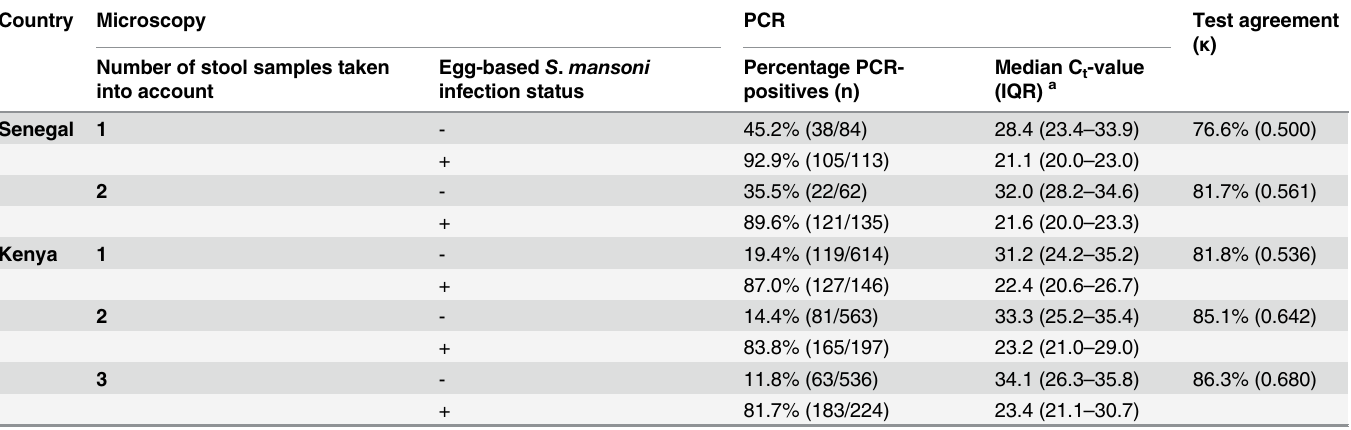
Table 2. PCR results in S . mansoni egg-positives and-negatives. Country